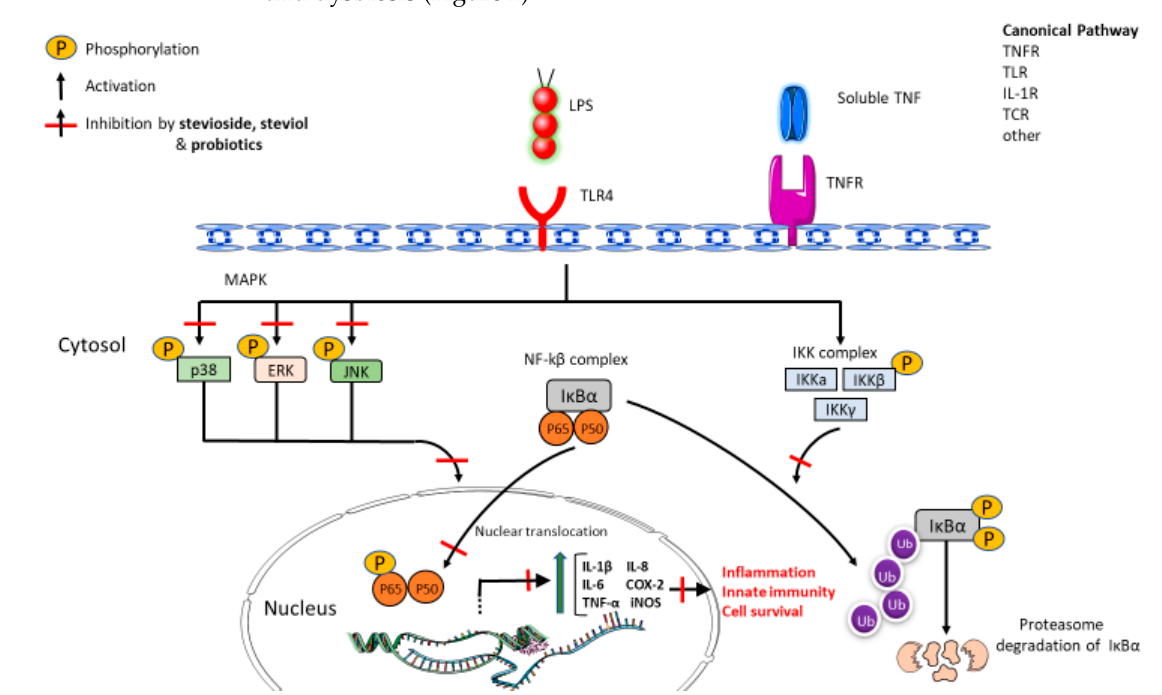
Figure 2. The anti-inflammatory effect of stevia glycosides through inhibition of transcription factor NF- κ B and mitogen-activated protein kinase (MAPK). Figure created using Servier Medical Art (www.servier.com; accessed on 28 January 2022) under a Creative Commons Attribution 3.0 Unported license.